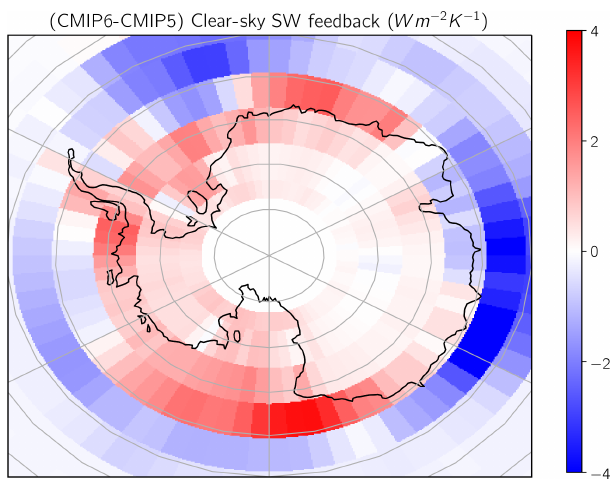
Figure 8. Map of the difference in clear-sky zonal feedbacks for the Antarctic region between CMIP6 and CMIP5. Red colors indicate that the CMIP6 feedback is larger than CMIP5, and blue indicates that CMIP6 is smaller than CMIP5. Averaged on a 5 ◦ by 5 ◦